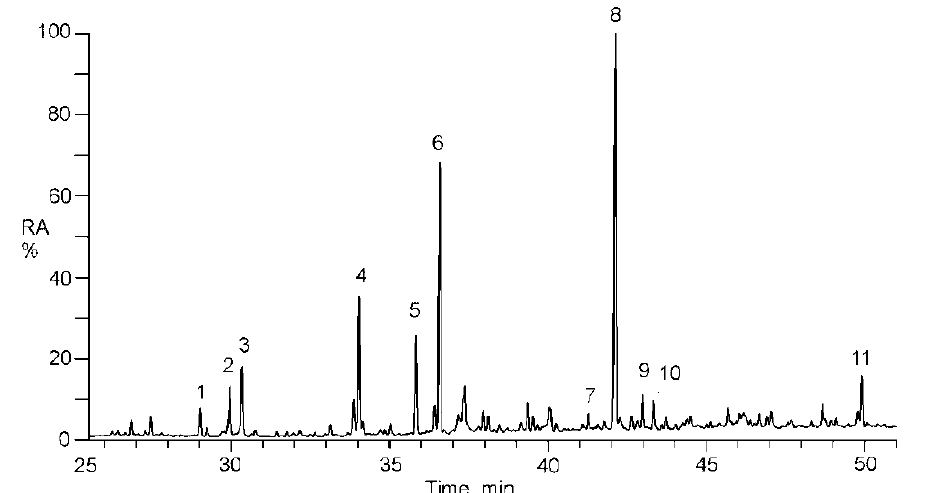
Figure 4. Total ion chromatogram illustrating the power of capillary GC/MS using prior trimethylsilylation for separating isoprene SOA markers obtained for a fine daytime HVDS filter sample collected during the transition period of the 2002 LBA-SMOCC campaign. (1, 2 and 3) C 5 -alkene triols; (4) malic acid; (5) 2-methylthreitol; (6) 2-methylerythritol; (7) mannosan; (8) levoglucosan; (9) 1,6-anhydro- β -D-glucofuranose; (10) arabitol; and (11) mannitol. Compound 4 (malic acid) is a marker for oxidation of unsaturated fatty acids; compounds 7, 8 and 9 (mannosan, levoglucosan, and 1,6-anhydro- β -D-glucofuranose) are markers for biomass burning, and compounds 10 and 11 (arabitol and mannitol) are markers for fungal spores (source: Claeys et al., 2010 [23]).